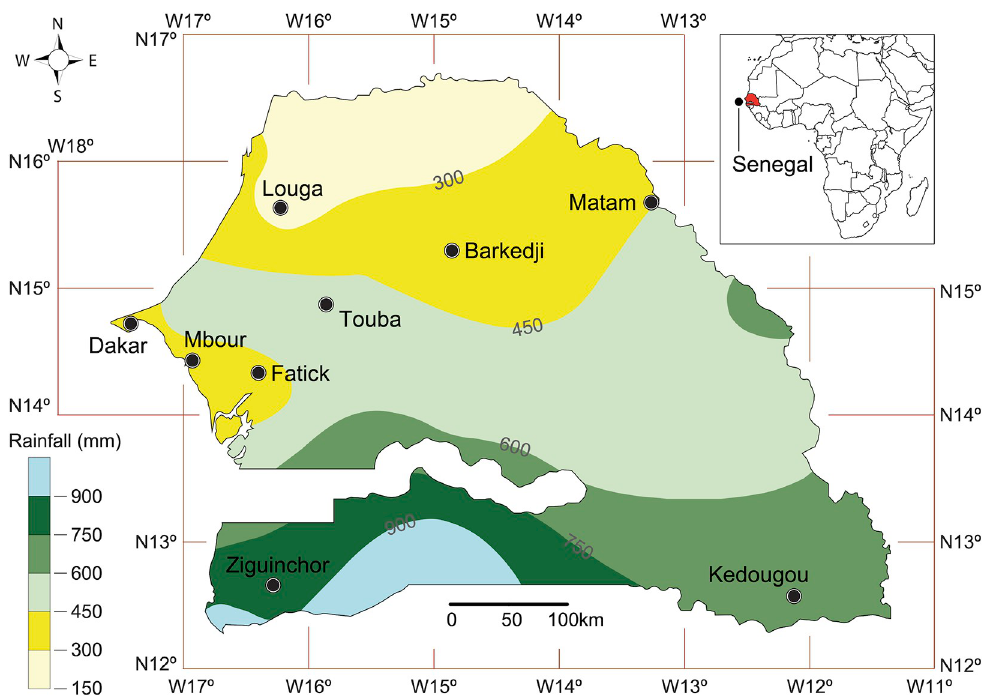
Fig 1. Map showing the nine sites where Ae . aegypti mosquitoes were collected and the different bioclimatic zones. This map was created using the R software (version 4.0.2) and the package rgdal using an empty shapefile from the HDX website (https://data.humdata.org/dataset/senegal-administrative-boundaries) available under Creative Commons Attribution 4.0 International